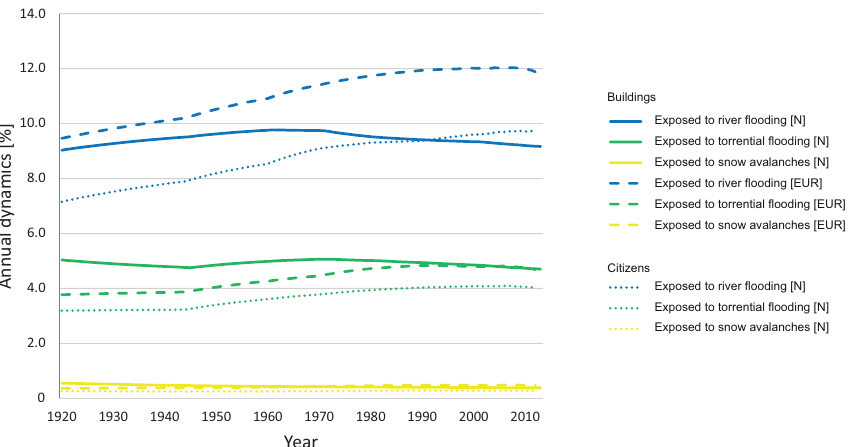
Figure 5. Relation between exposed buildings and residents and the total building stock and total number of residents. The numbers are based on average annual construction activities based on the available construction